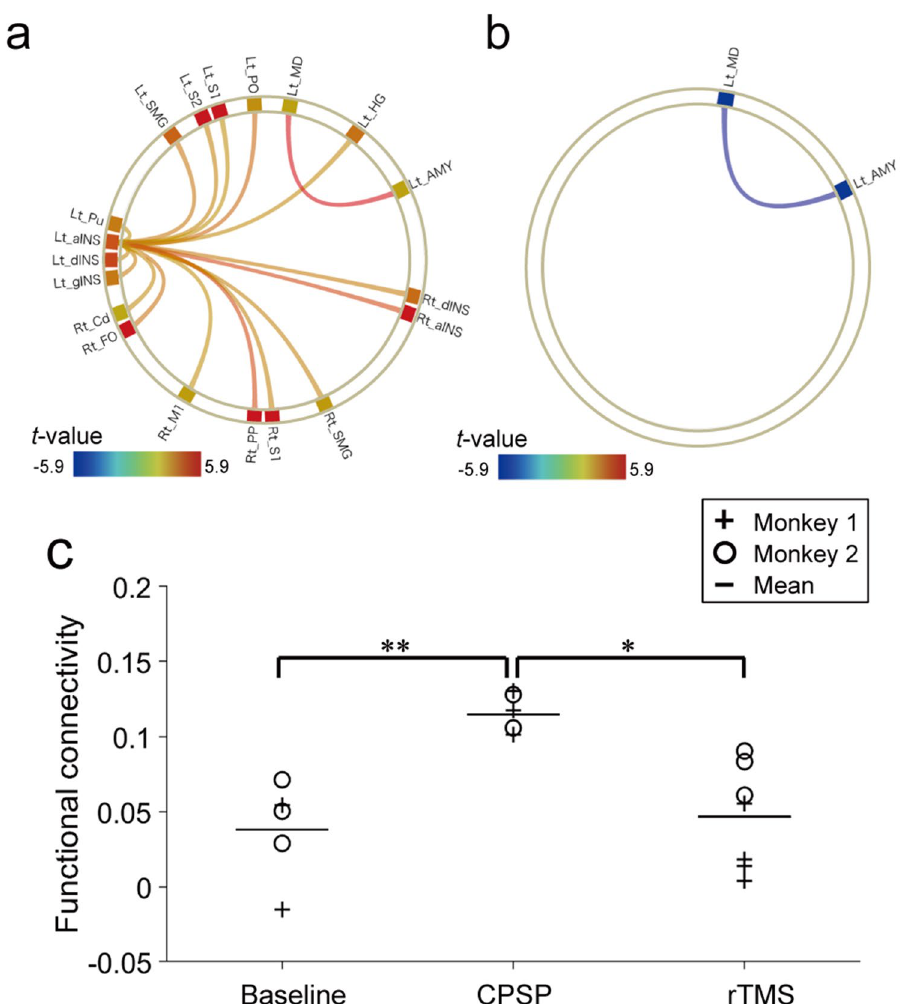
Figure 4. Changes in resting-state functional connectivity obtained from ROI-to-ROI analysis. ( a ) Changes in functional connectivity between the baseline and after CPSP development and ( b ) between the CPSP and after rTMS treatment. The red and blue lines indicate increased and decreased functional connectivity, respectively. The graphical figures are made by Conn toolbox. ( c ) The values of the functional connectivity between the left amygdala and the left MD for the two monkeys are shown. * p < 0.005, ** p < 0.00005 after Bonferroni correction. aINS agranular insular cortex, AMY amygdala, Cd caudate, CPSP central poststroke pain, dINS dysgranular insular cortex, FO frontal operculum, gINS granular insular cortex, HG Heshcel’s gyrus, Lt left, M1 motor cortex, MD mediodorsal nucleus of the thalamus, PO Parietal operculum cotex, PP planum polare, Pu putamen, ROI region of interest, Rt right, rTMS repetitive transcranial magnetic stimulation, S1 primary somatosensory cortex, S2 secondary somatosensory cortex, SMG supramarginal